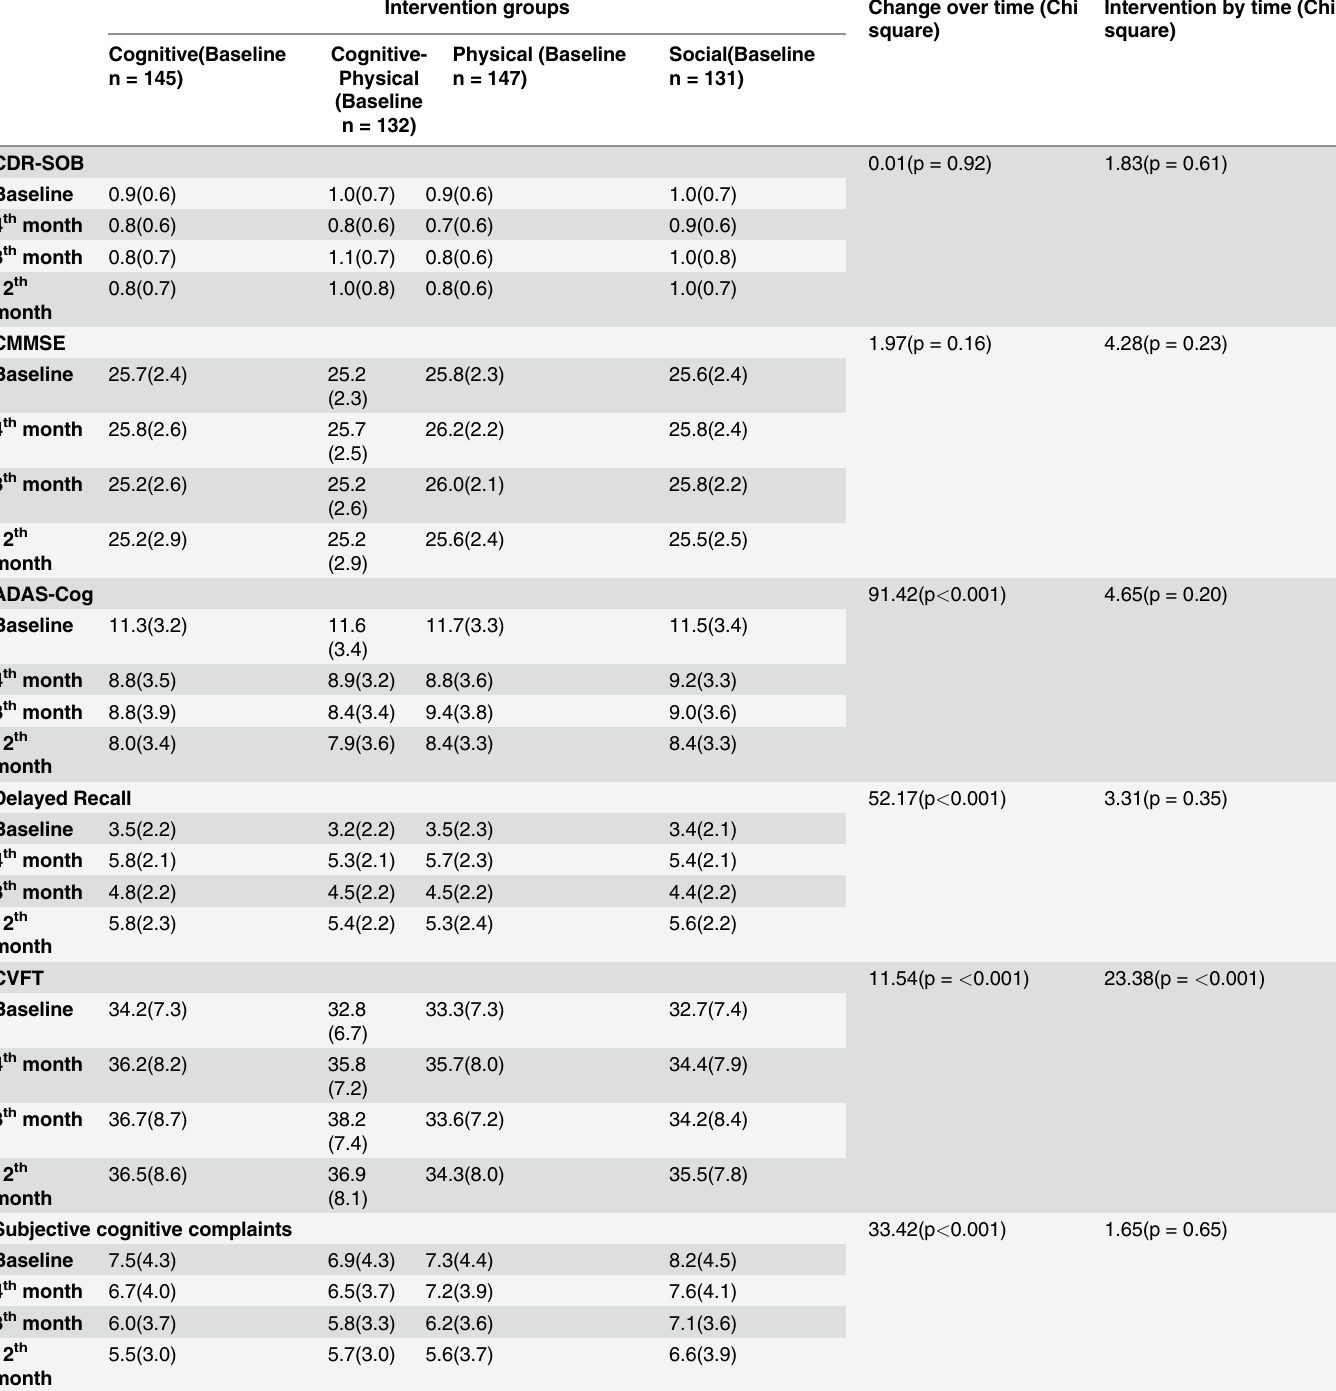
Table 3. Effects of activity intervention on cognitive and mood outcomes for all participants (Intention-to-treat method). Intervention groups Change over time (Chi Intervention by time (Chi square)